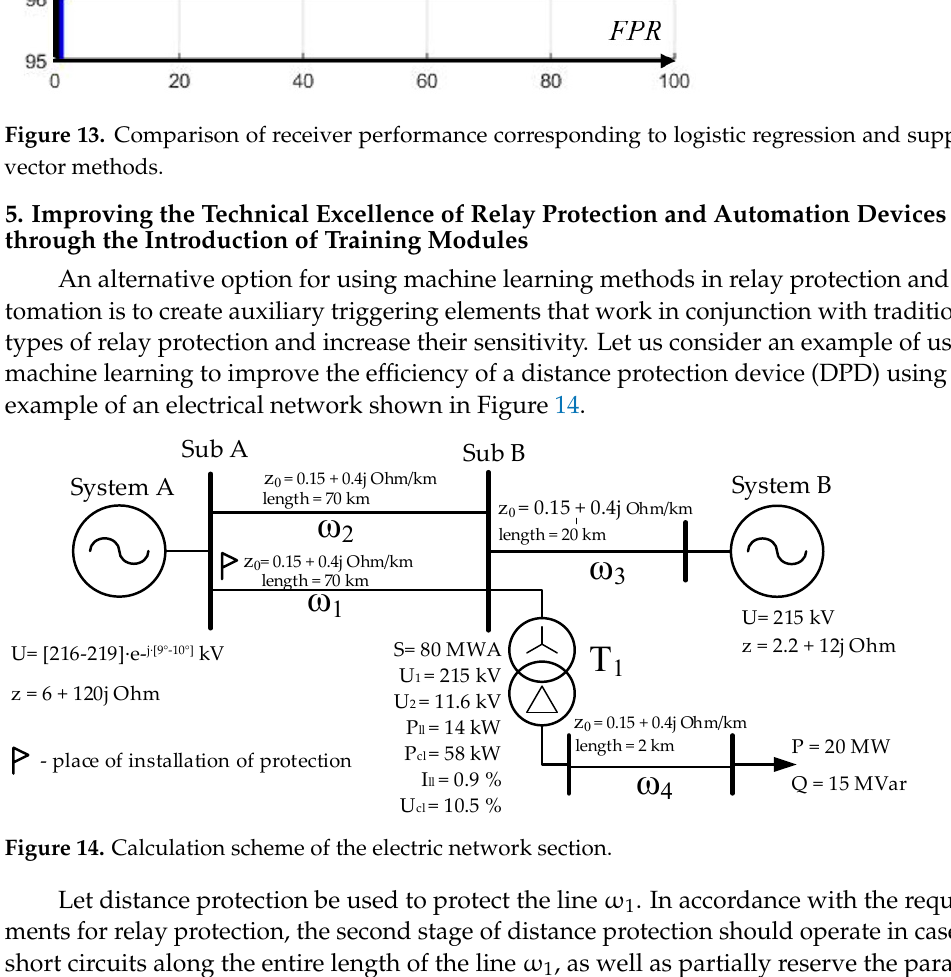
Figure 13. Comparison of receiver performance corresponding to logistic regression and support vector methods.